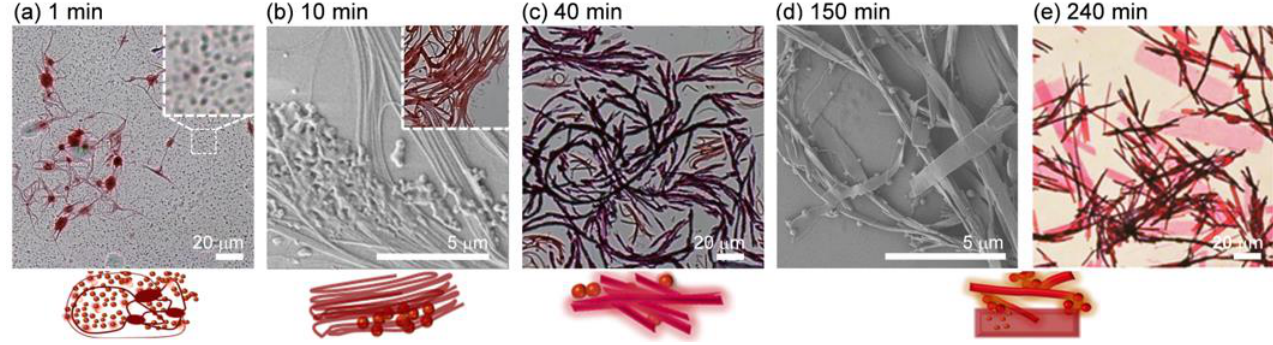
Figure 7. OM ( a , inset image in b , c , e ) and SEM ( b , d ) images showing the morphological growth processes of 3Bu THF-H 2 O (1/1, v / v ) mixtures according to storage time at 10 – 15